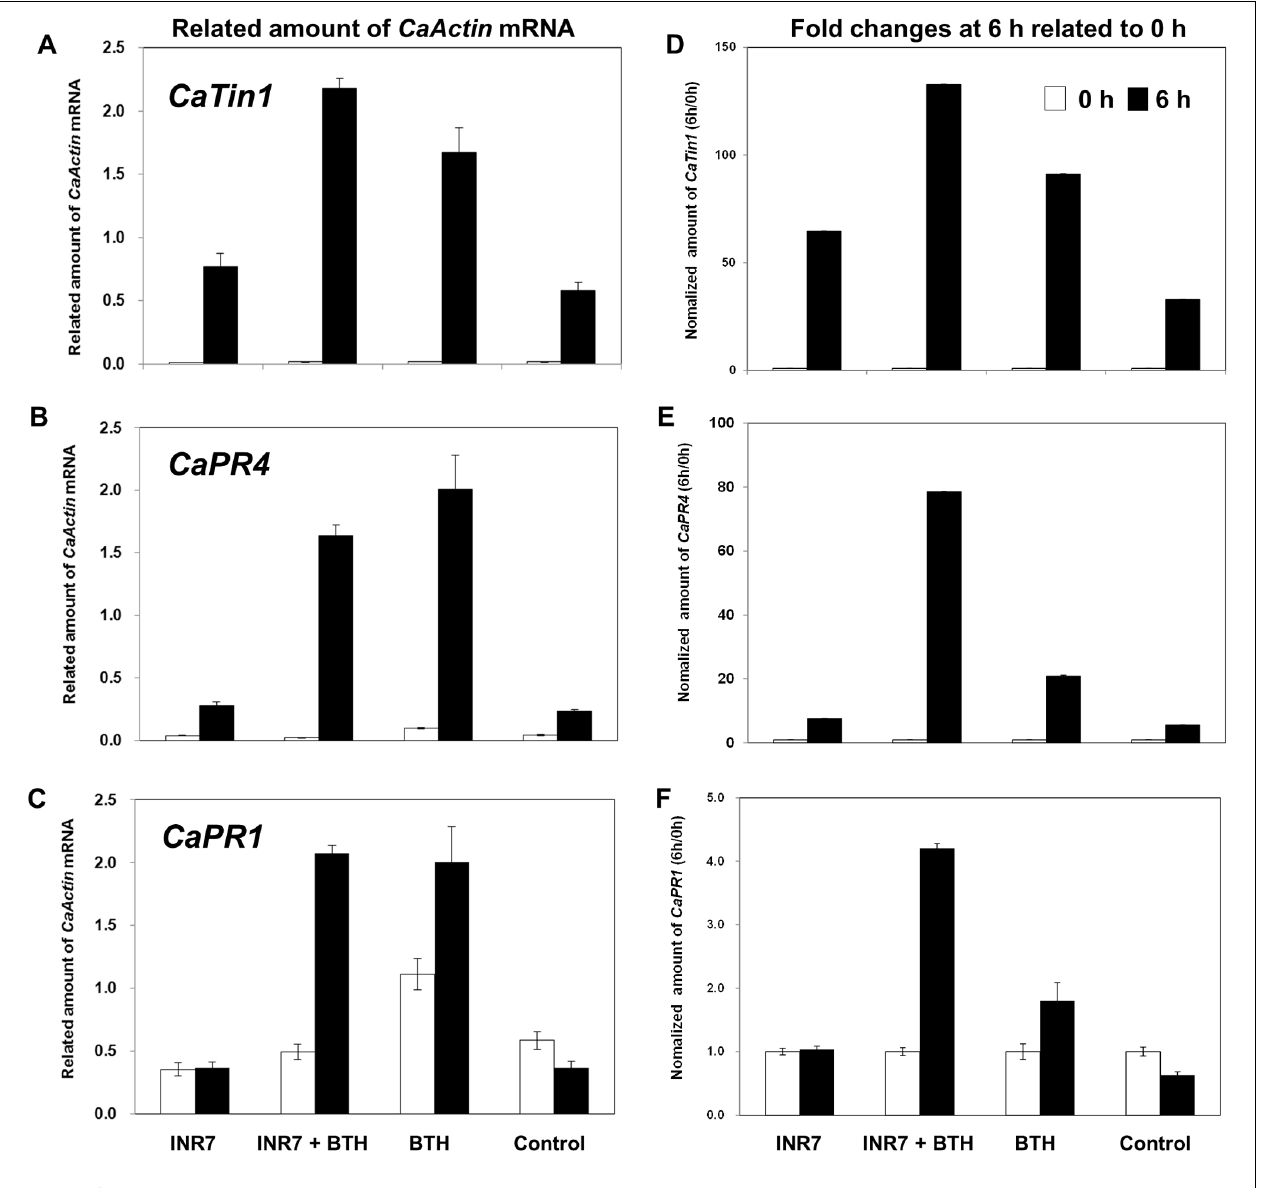
FIGURE 3 | Defense priming of CaTin1, CaPR4, and CaPR1 genes in strain INR7, BTH, INR7 + BTH, and water-treated pepper plants by pathogen challenge under field condition. The expression levels of pepper defense-related genes CaTin1 (A) , CaPR4 (B) , and CaPR1 (C) and their